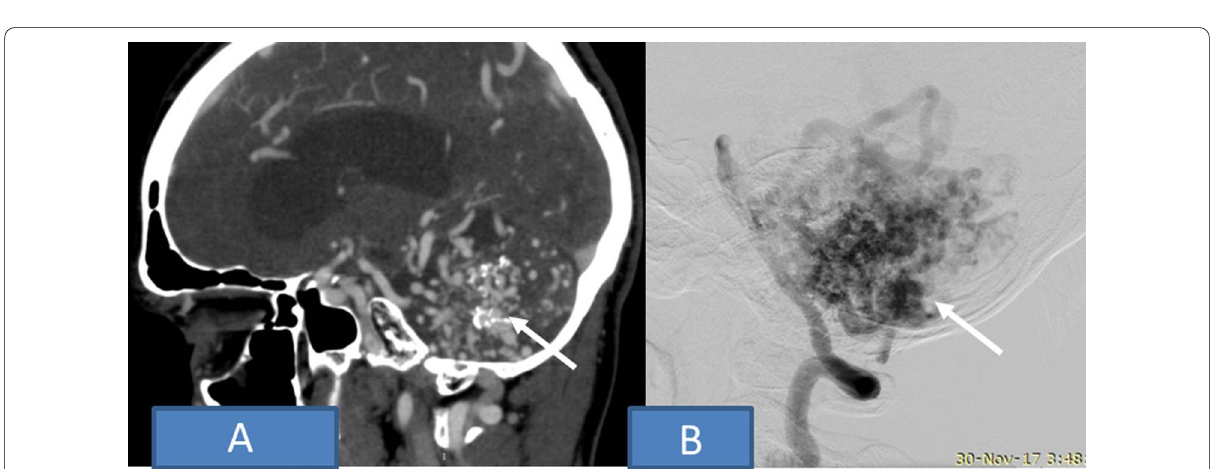
Fig. 2 Pial AVM; a Sagittal MIP image, and b DSA image in lateral view in the same patient showing pial AVM in the posterior fossa with tangle of vascular channels—nidus (white arrows)—with enlarged draining